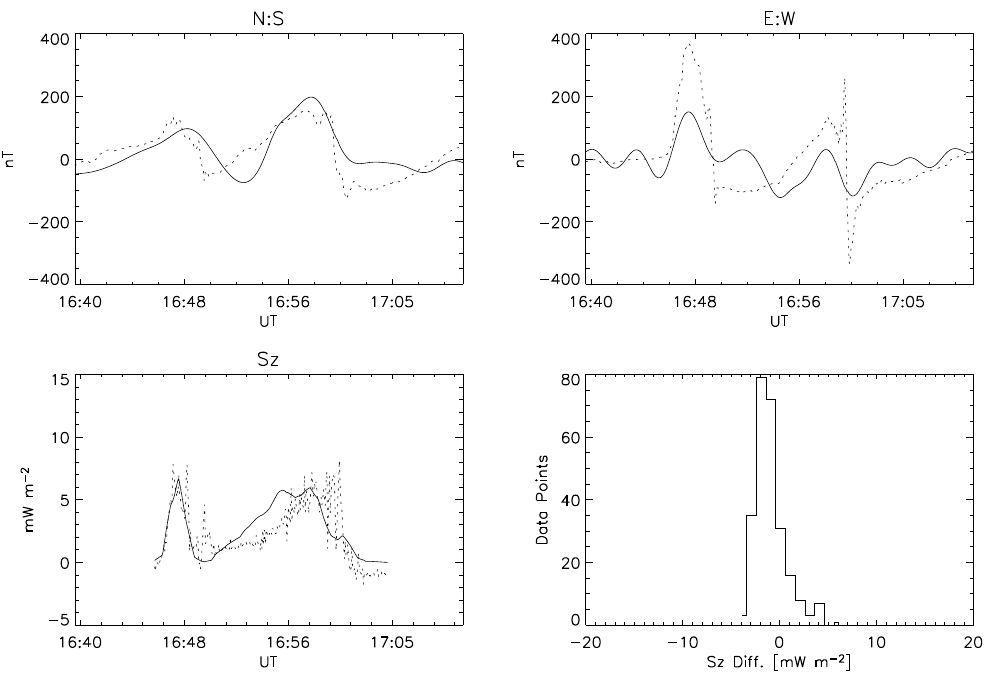
Fig. 3. Comparison of DMSP F-15 data with Iridium/SuperDARN values for 11 March 2000 (top panels) DMSP F-15 and Iridium derived magnetic field values in north-south (left panel) and east-west (right panel) components. (lower panels) Poynting flux data along the DMSP track from 20.3 to 9.3 MLT (left panel) and a histogram of the differences in Poynting flux (right panel).